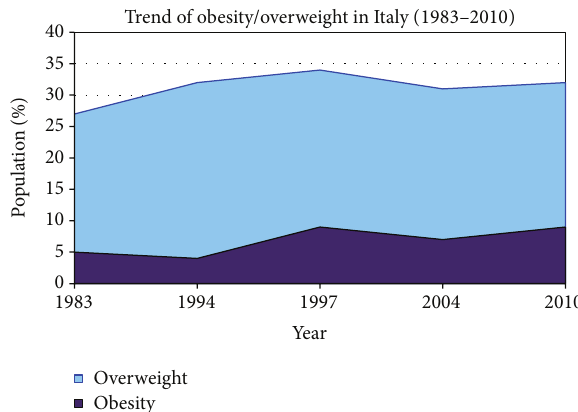
Figure 3: Trend of overweight and obesity in Italian population (1983–2010) [10,